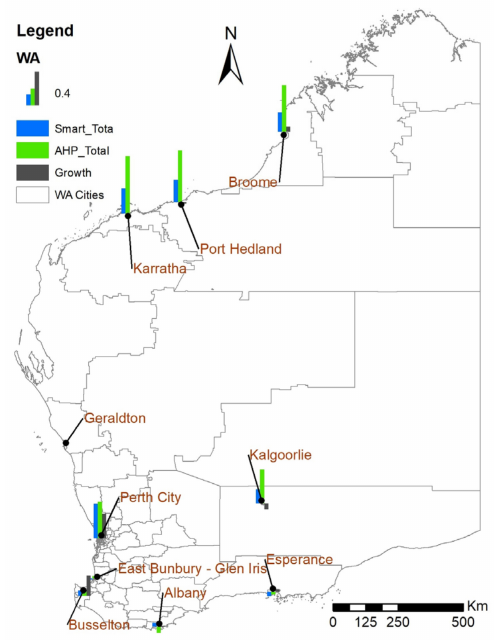
Figure 13. Smart and preferred city rankings of Western Australian 10 cities and the population growth